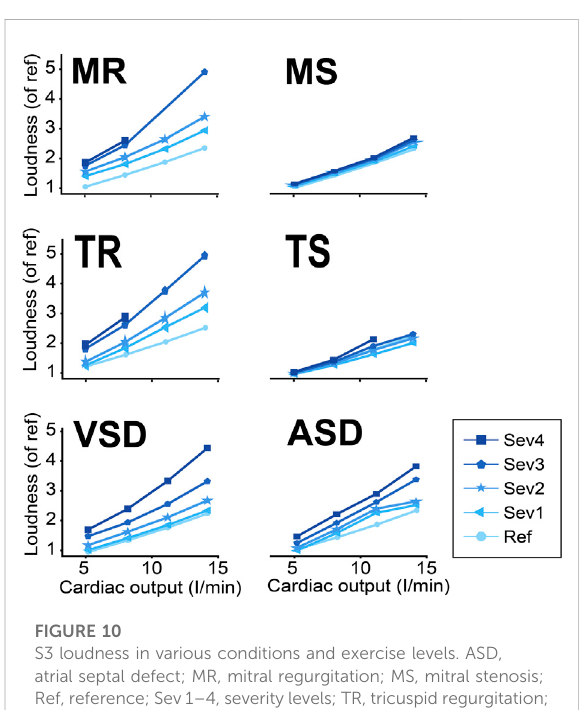
FIGURE 10 S3 loudness in various conditions and exercise levels. ASD, atrial septal defect; MR, mitral regurgitation; MS, mitral stenosis; Ref, reference; Sev 1 – 4, severity levels; TR, tricuspid regurgitation; TS, tricuspid stenosis; VSD, ventricular septal defect.